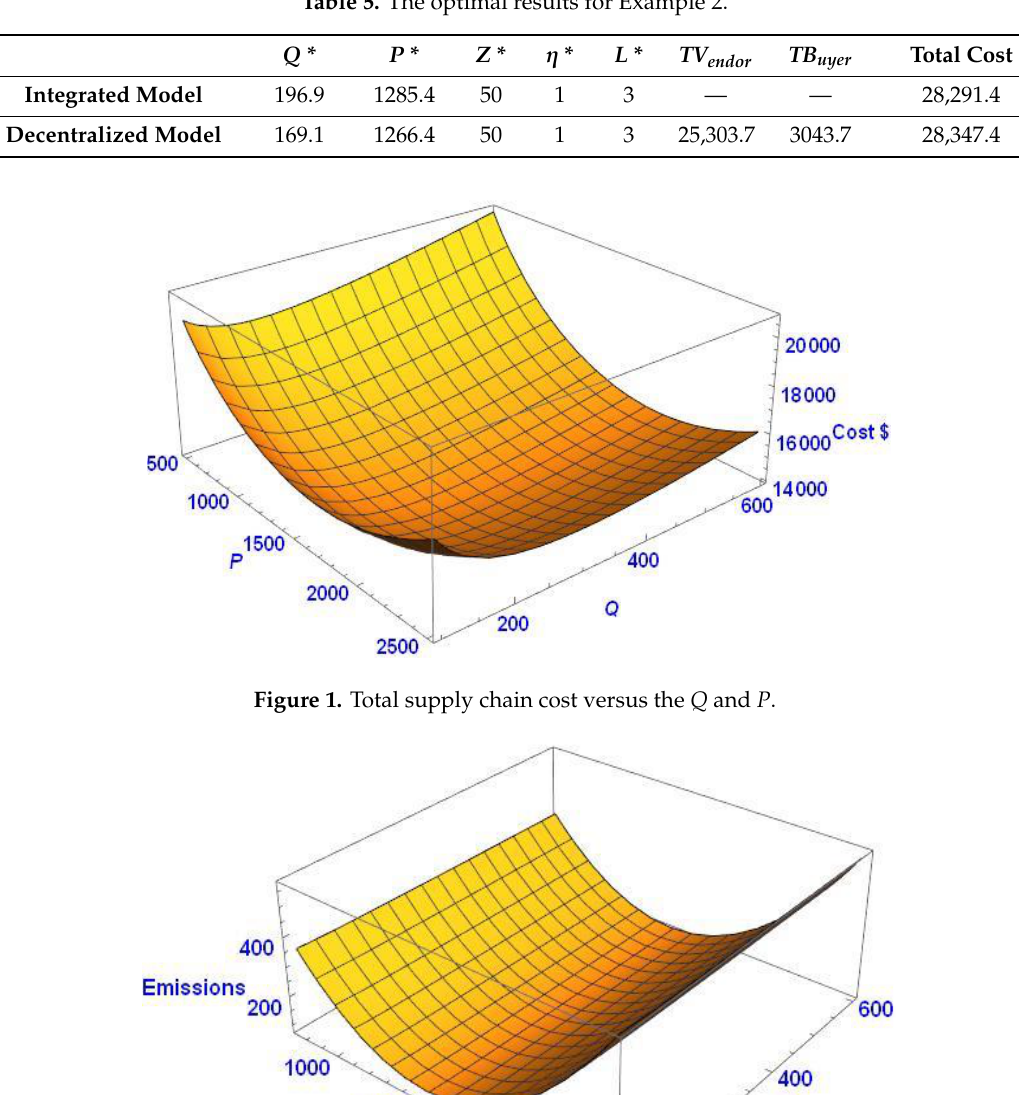
Table 5. The optimal results for Example 2.